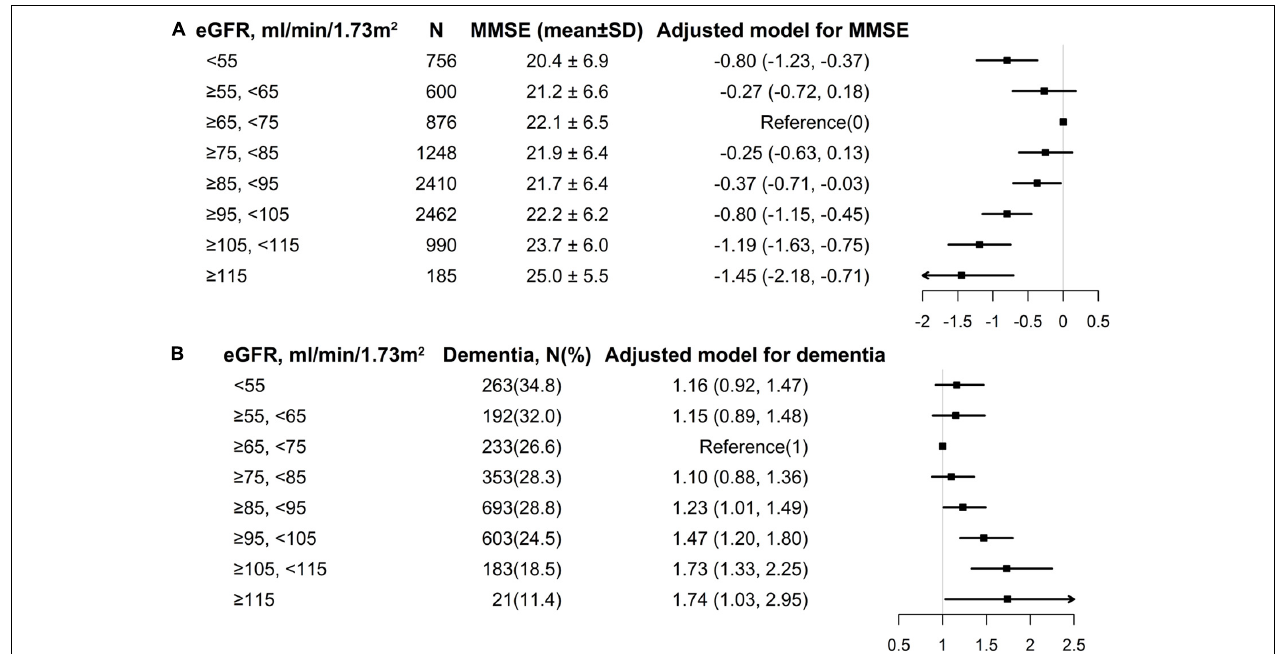
FIGURE 2 | Multivariate logistic regression of eGFR with MMSE and dementia among individuals divided into 10 ml/min/1.73 m 2 intervals of eGFR levels. (A) eGFR with MMSE; (B) eGFR with dementia. Each black square represents the effect size of the study together with the 95% CI. (A) eGFR with MMSE; (B) eGFR with dementia. All analyses were adjusted for sex, age, body mass index, systolic blood pressure, diastolic blood pressure, education (except in Figure 1B ), coronary heart disease, diabetes mellitus, smoking status, alcohol consumption, homocysteine, total cholesterol, triglycerides, high-density lipoprotein, and antihypertensive